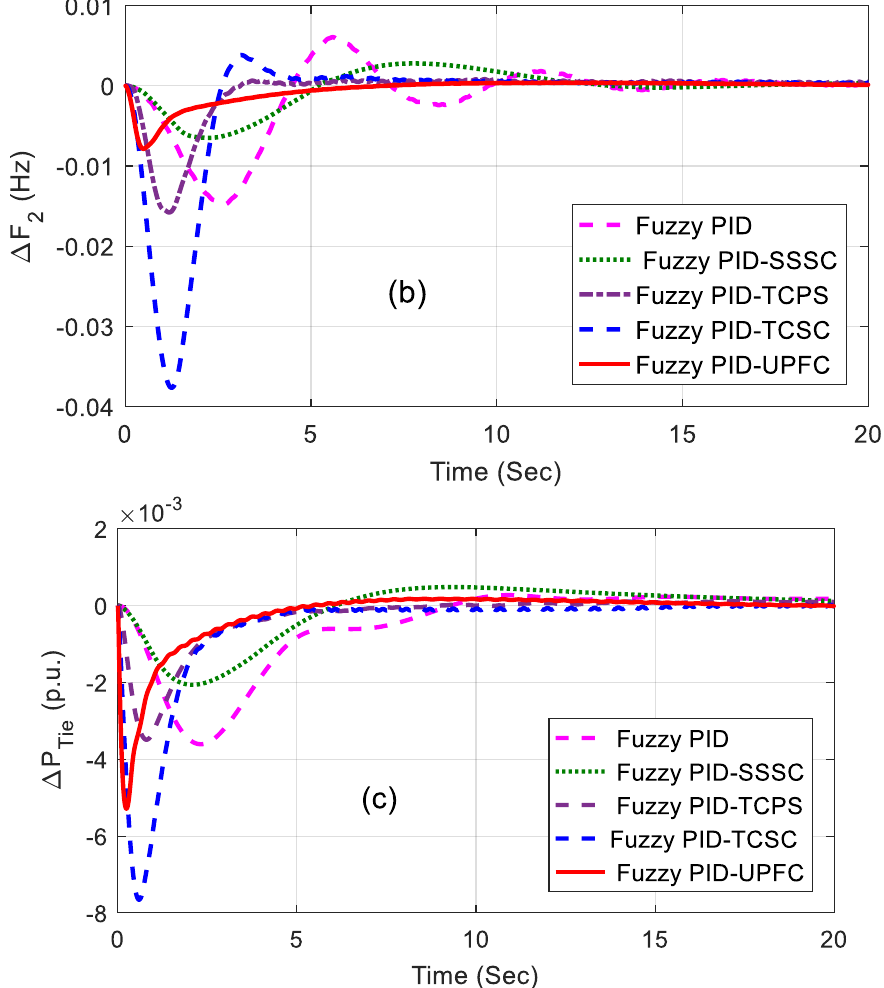
Figure 6. ( a – c ) Dynamic performance of 1% step load perturbation (SLP) in area1.